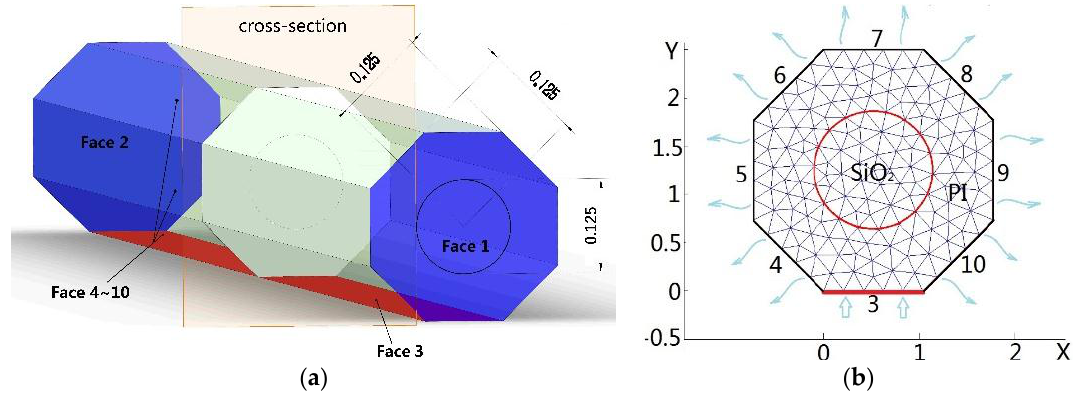
Figure 2. Temperature field model of FBG sensor. ( a ) 3D model of FBG sensor and ( b ) 2D heat conductivity model on the cross-section.